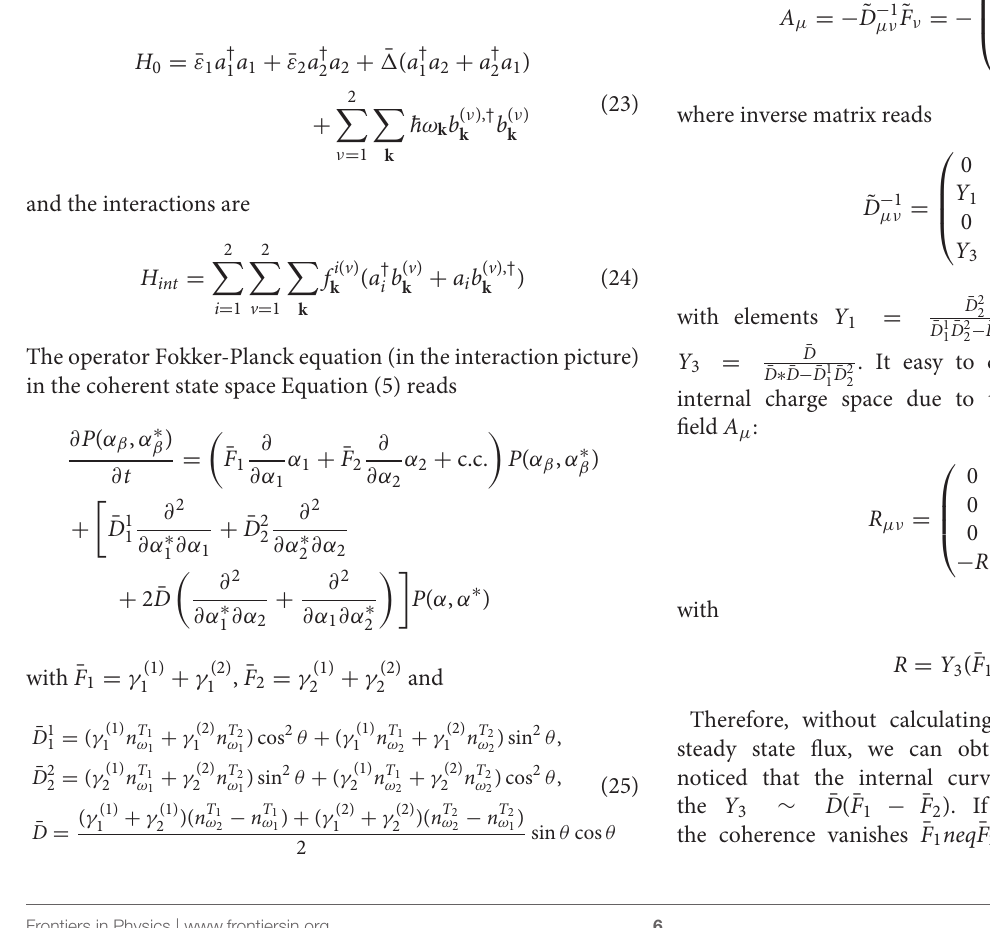
4 ps , F 2 8 ps , and F 2 = = 0.5 ev , 1 0.3 ev = =